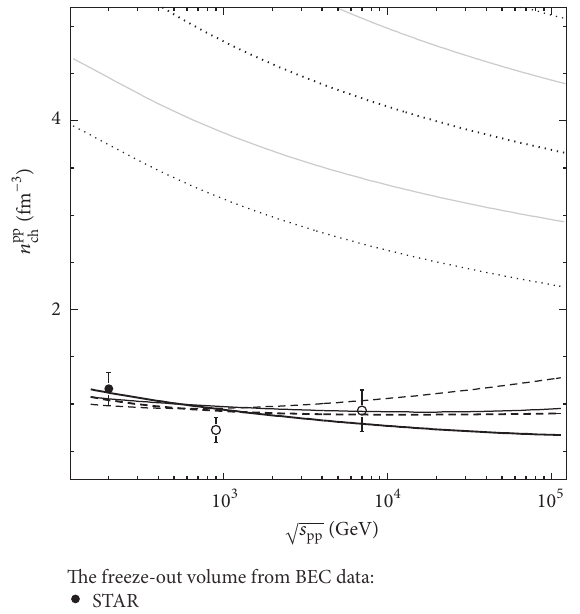
Figure 5: Energy dependence of estimations for charged particle density and for critical one in 𝑝 + 𝑝 collisions. Points are calculated [17] and the experimental with help of the hybrid function for 𝑁 ch estimations for 𝑉 and uncertainties for points are propagated from statistical errors of measurements and fits used. Solid lines [17] and dashed lines correspond to the hybrid approximation of 𝑁 ch are for 3NLO pQCD equation [18] while thick lines show results with 𝑉 calculated with the fits of BEC radii by (7) in case (ii.1) and thin lines with the fits by specific case 𝑅 𝑖 ∝ ln 𝜀, 𝑖 = 𝑠,𝑙. Critical charged particle density is shown by dotted line with its statistical uncertainty levels represented by thin dotted lines. The heavy grey calculatedbyvarying linescorrespondtothesystematic ±1 s.d.of 𝑛 ch of 𝜂 on ±0.05